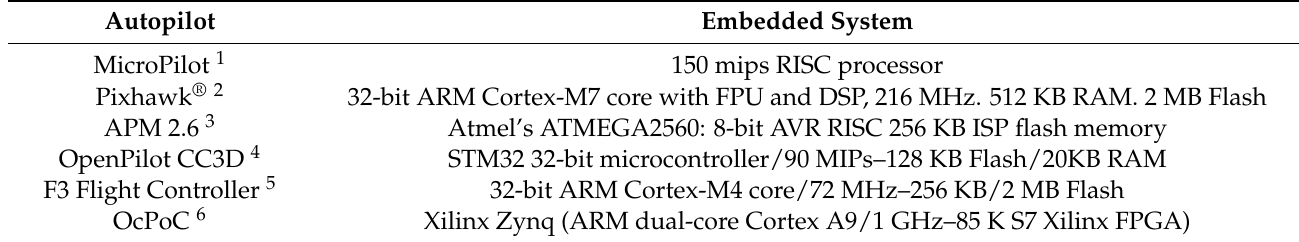
Table 3. Common off-the-shelf autopilot for unmanned aircraft under 20